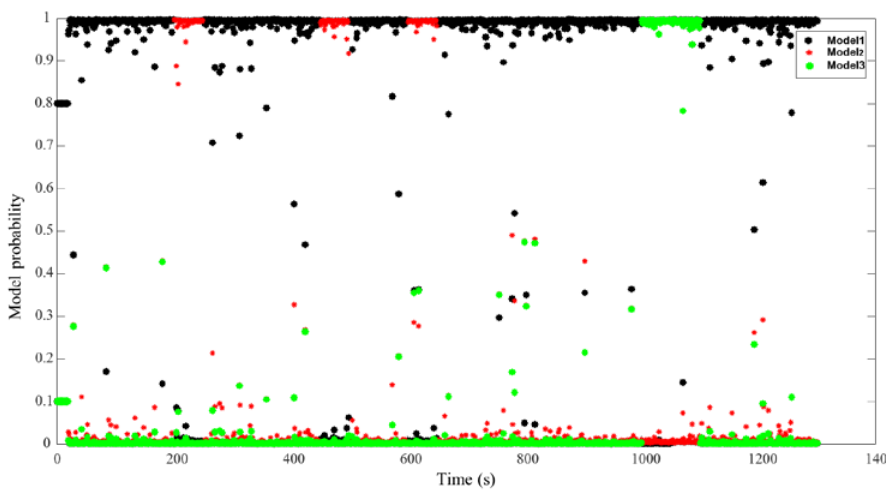
Figure 15. Model probability of IMM.